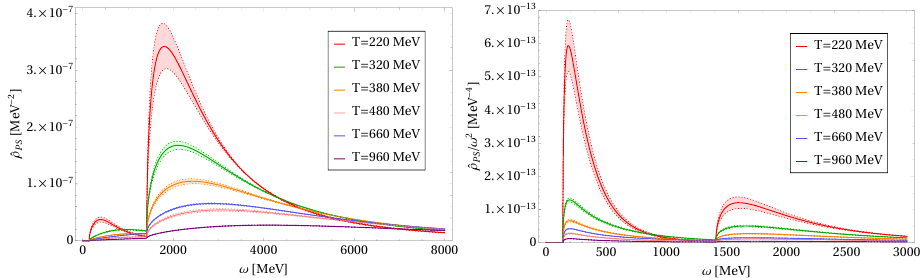
Figure 1: The unit-normalised pseudo-scalar spectral function ˆ ρ PS ( ω ) (left), and rescaled expression ˆ ρ PS ( ω ) /ω 2 (right), at di ff erent temperatures for m π = 140 MeV. The coloured bands indicate the 1 σ